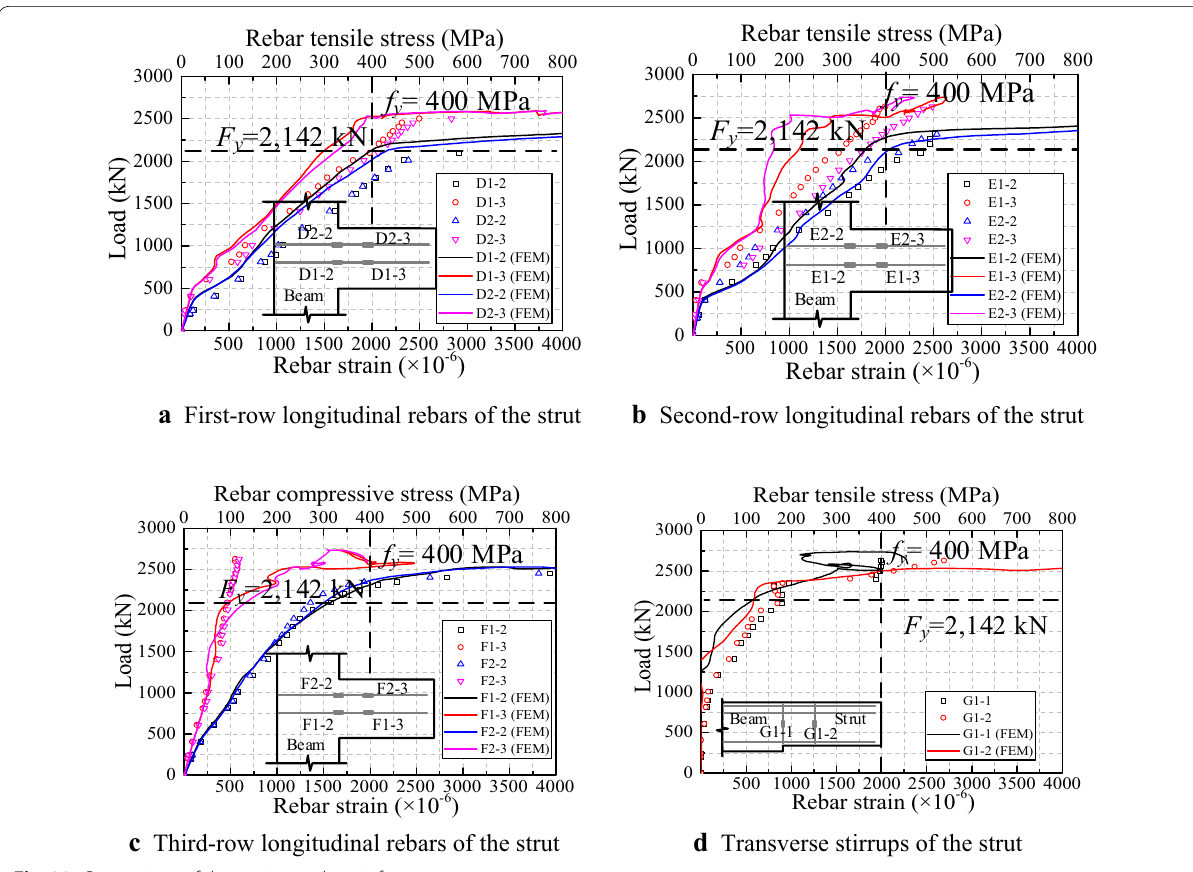
Fig. 22 Comparison of the strains on the reinforcements.